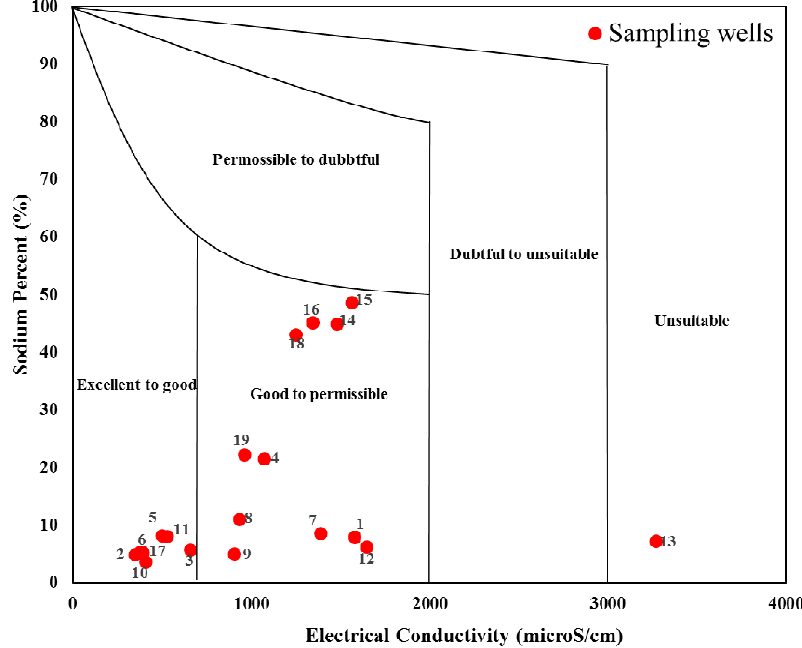
Figure 4. Rating of groundwater samples based on electrical conductivity (EC) and Na content.